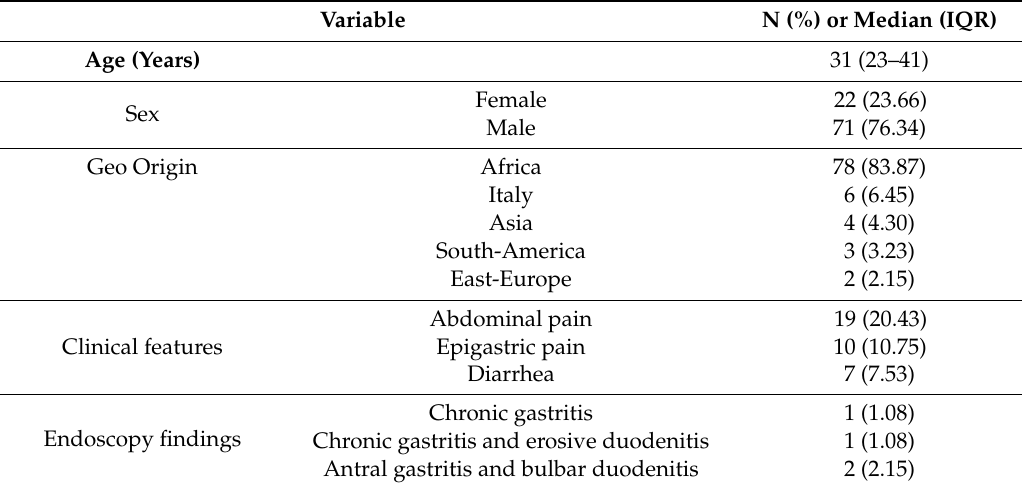
Table 1. Baseline characteristics of the screened subjects (N = 93).